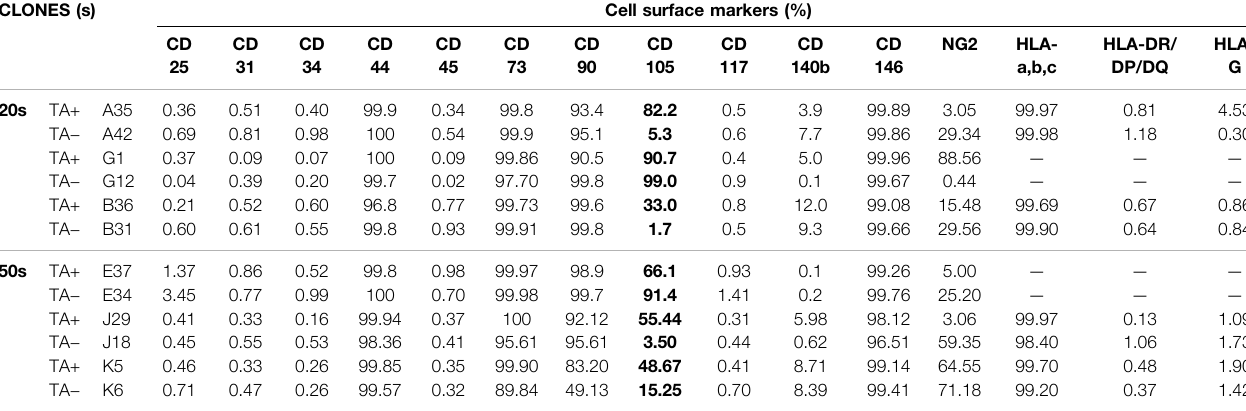
TABLE 3 | Cell surface markers of USC TA+ and USC TA − clones at passage four detected using fl uorescence-activated cell sorting. CLONES (s)